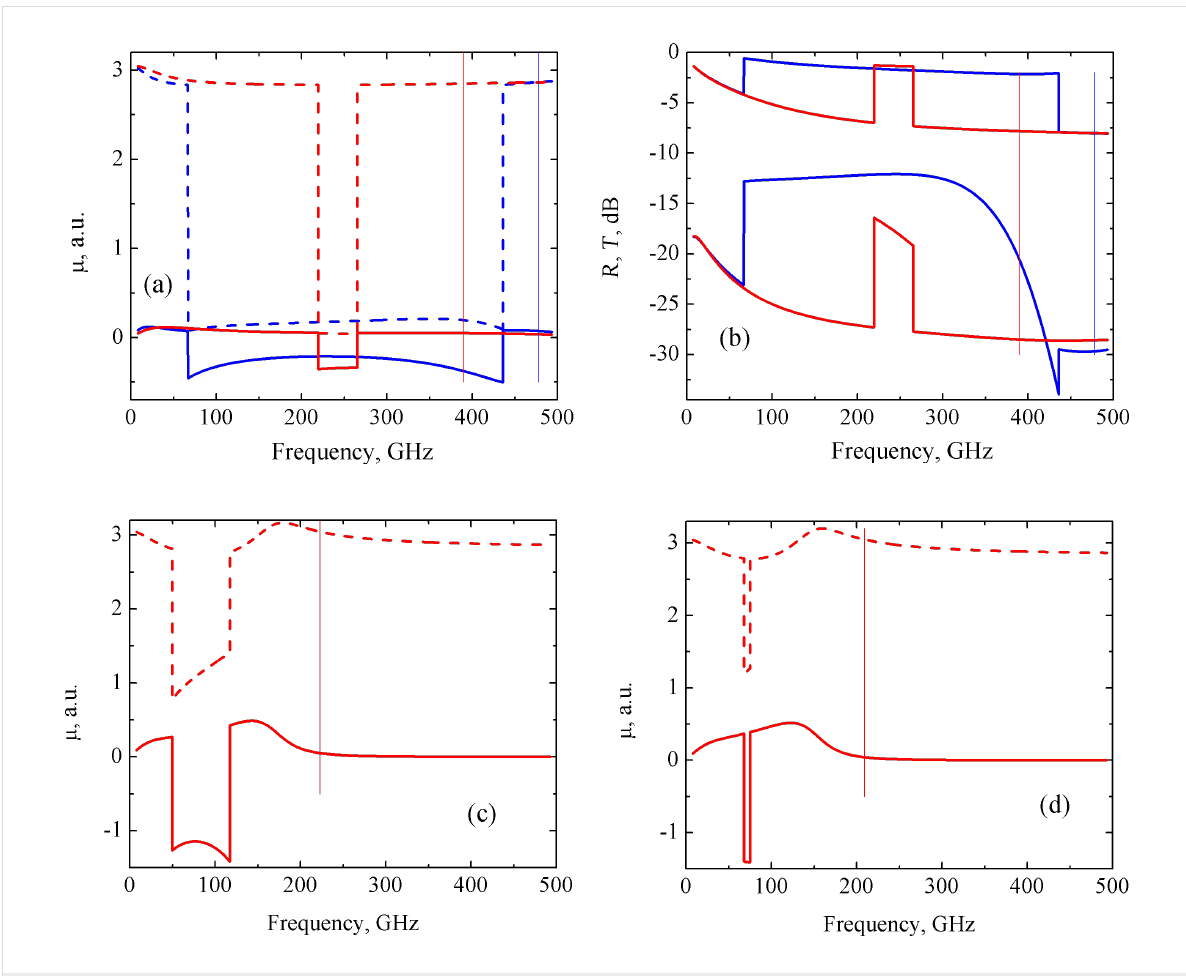
Figure 2: Frequency dependencies of the real (dashed lines) and imaginary (solid lines) parts of the permeability (a,c,d), and of the reflection R (upper curves) and transmission T (lower curves) coefficients (b) of the CNT based nanocomposite consisting of partially parallel circuit: (a) – R i = 0.01 Ω , L i = 0.01 pH, C i = 10 pF ( ω 0 = 477.5 GHz) – blue curves; R i = 0.02 Ω , L i = 0.01 pH, C i = 10 pF ( ω 0 = 390.0 GHz) – red curves; (b) – R i = 0.01 Ω , L i = 0.01 pH, C i = 10 pF ( ω 0 = 477.5 GHz) – blue curves; R i = 0.02 Ω , L i = 0.01 pH, C i = 10 pF ( ω 0 = 390.0 GHz) – red curves; (c) – R i = 0.01 Ω , L i = 0.05 pH, C i = 10 pF ( ω 0 = 223.0 GHz); (d) – R i = 0.01 Ω , L i = 0.0569 pH, C i = 10 pF ( ω 0 = 209.0 GHz). Resonance frequencies of the R i L i C i circuits ω 0 are drawn by vertical lines of corresponding